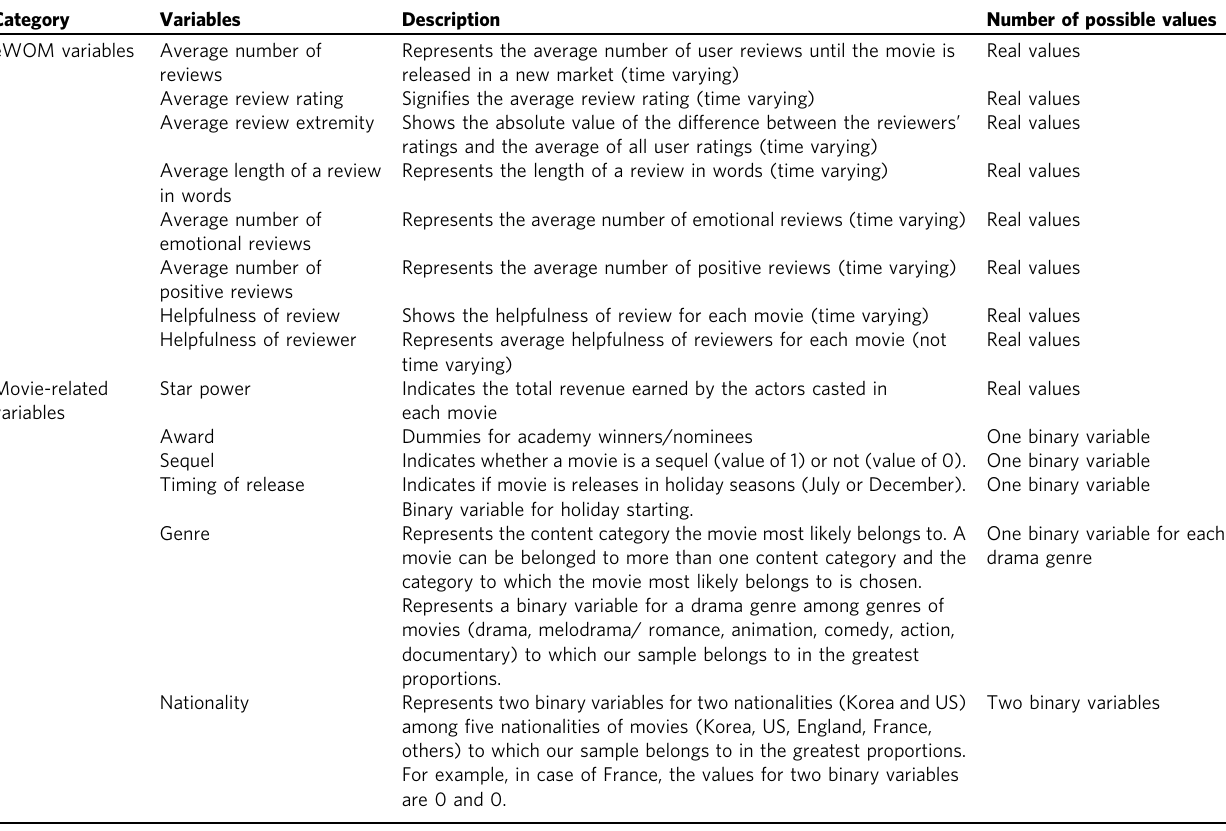
Table 2 eWOM and movie related variables.